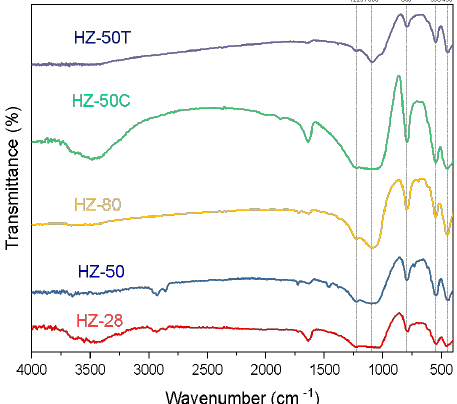
Fig. 1. FTIR spectra of the different ZSM-5 zeolites. Fig. 2 . XRD patterns of the different ZSM-5 zeolites.